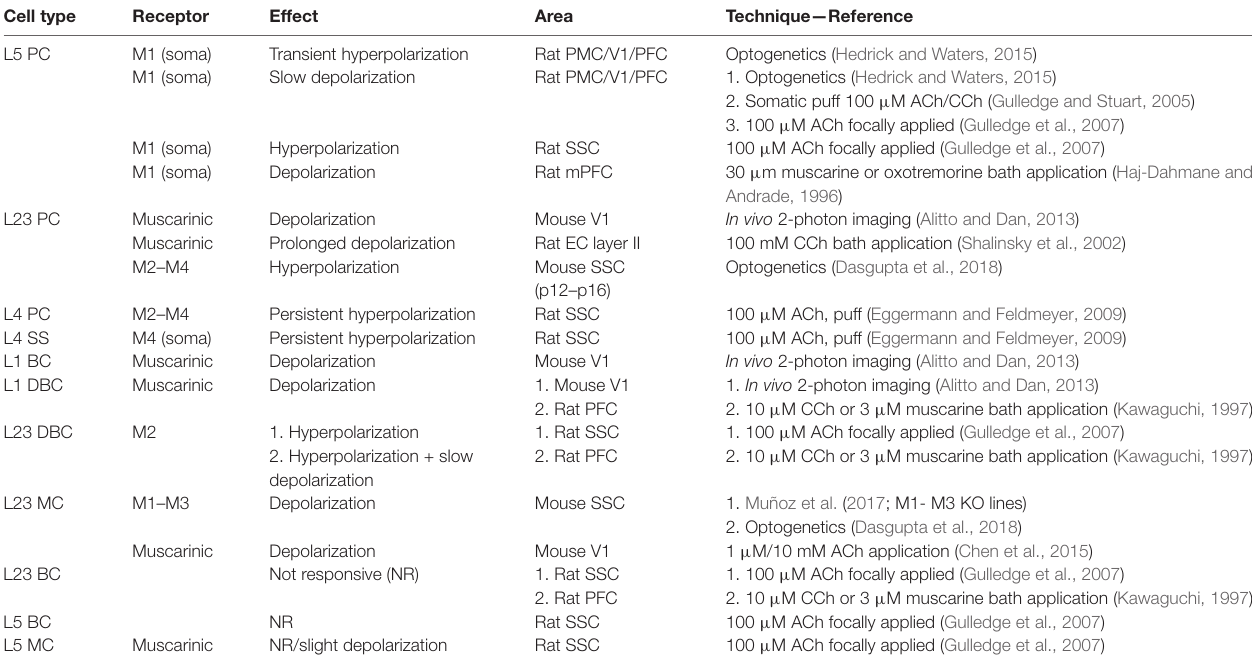
The table links the distribution and localization (when known, in brackets) of muscarinic receptors across neocortical cell types, with respect to cortical layers, with the effect of their activation. The effect of receptor activation is represented in terms of variation of membrane potential. Age of the specimen is given in brackets, when known. When biphasic effects occur, they are listed as multiple effects. Inclusion criteria for the listed studies comprise: (1) recordings performed in the rodent neocortex; (2) knowledge of the morphological type involved; and (3) knowledge of the receptor subtype involved in the response. Abbreviations: PC, pyramidal cell; SS, spiny-stellate cell; IN, interneuron; MC, Martinotti cell; BC, basket cell; DBC, double-bouquet cell; NGFC, neurogliaform cell; BPC, bipolar cell, NBC, nest basket cell; RS, regular spiking. PMC, primary motor cortex; V1, primary visual area; PFC, prefrontal cortex; mPFC, medial prefrontal cortex; EC, entorhinal cortex; SSC, somatosensory cortex, ACh, acetylcholine; CCh, carbachol.